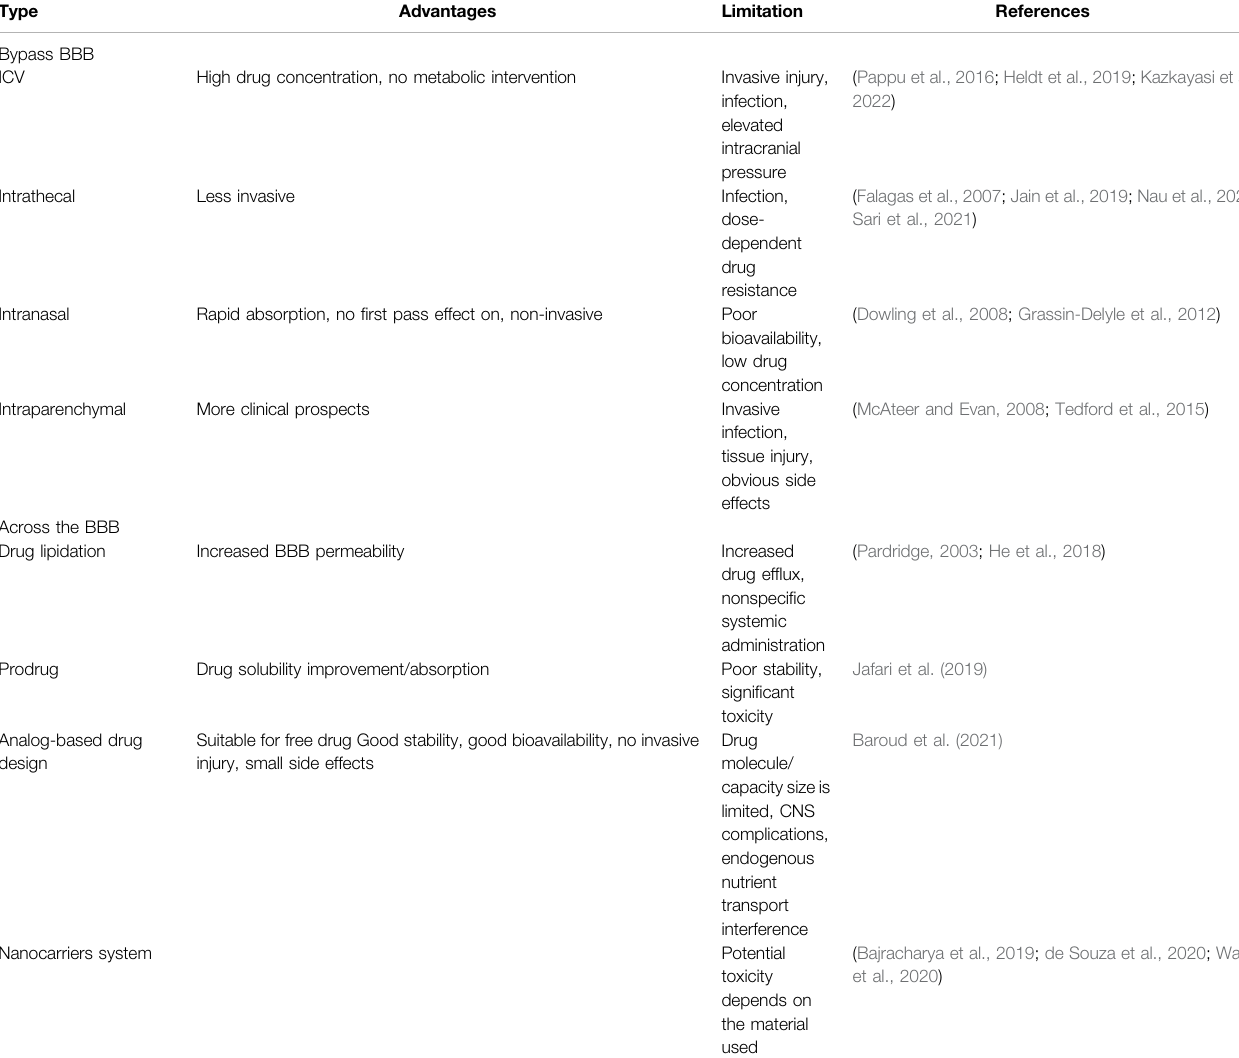
TABLE 2 | Strategies for drug delivery to access the